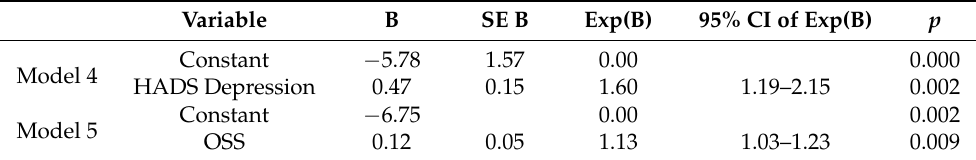
Table 4. Logistic regression analysis for the prediction of CSI classification (central or non-central sensitization) from the different psychological states and the functional variables of patients with chronic shoulder pain ( N =